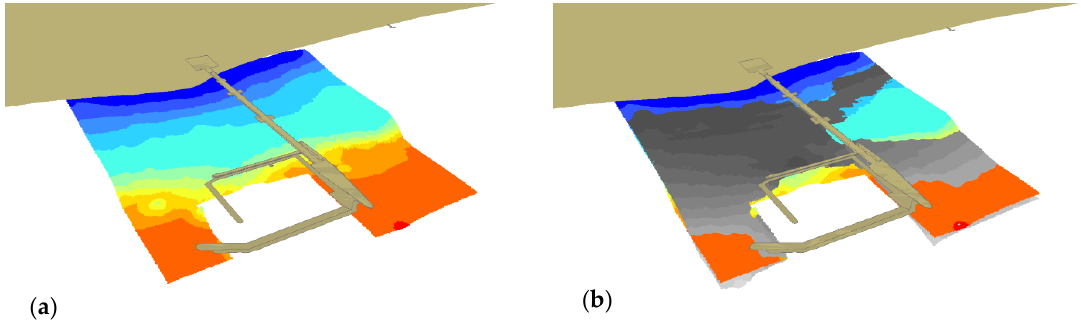
Figure 11. 3D bottom model based on the 2014 ( a ) and 2018 ( b ) ENC data.